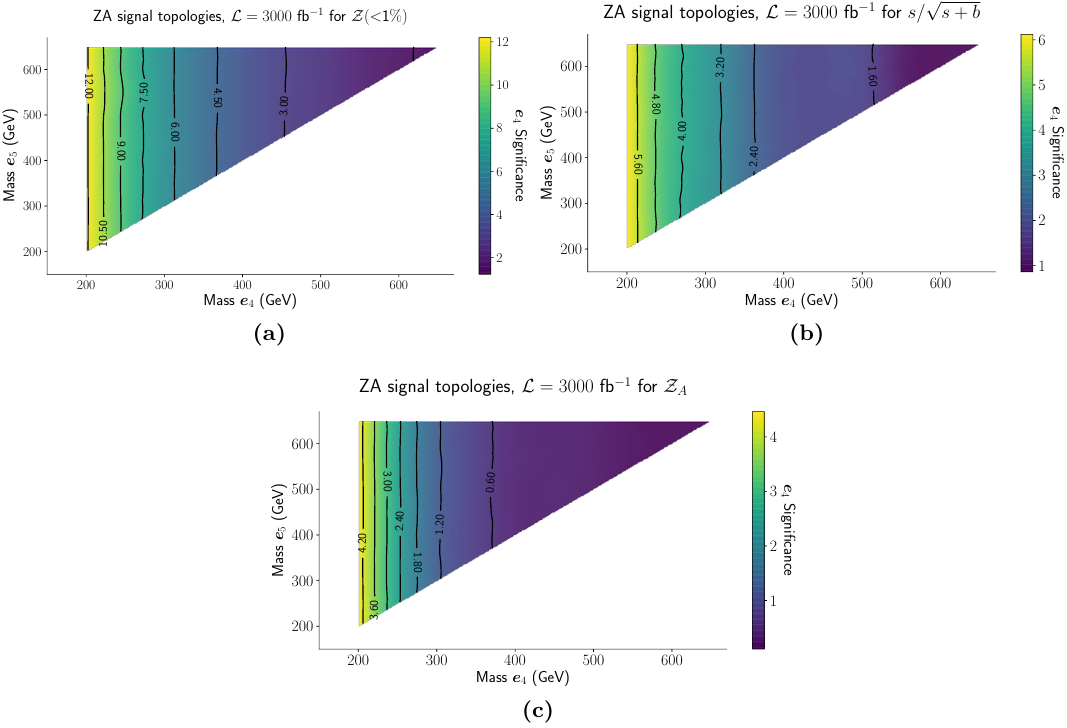
√ Figure 14. Significance contour plots for (a) Z ( < 1%) , (b) s/ s + b and (c) Z A . The colour scale represents a ZA event signal for e at a luminosity of L = 3000 fb − 1 . The significance is computed 4 with an evolutive algorithm that maximises the Asimov